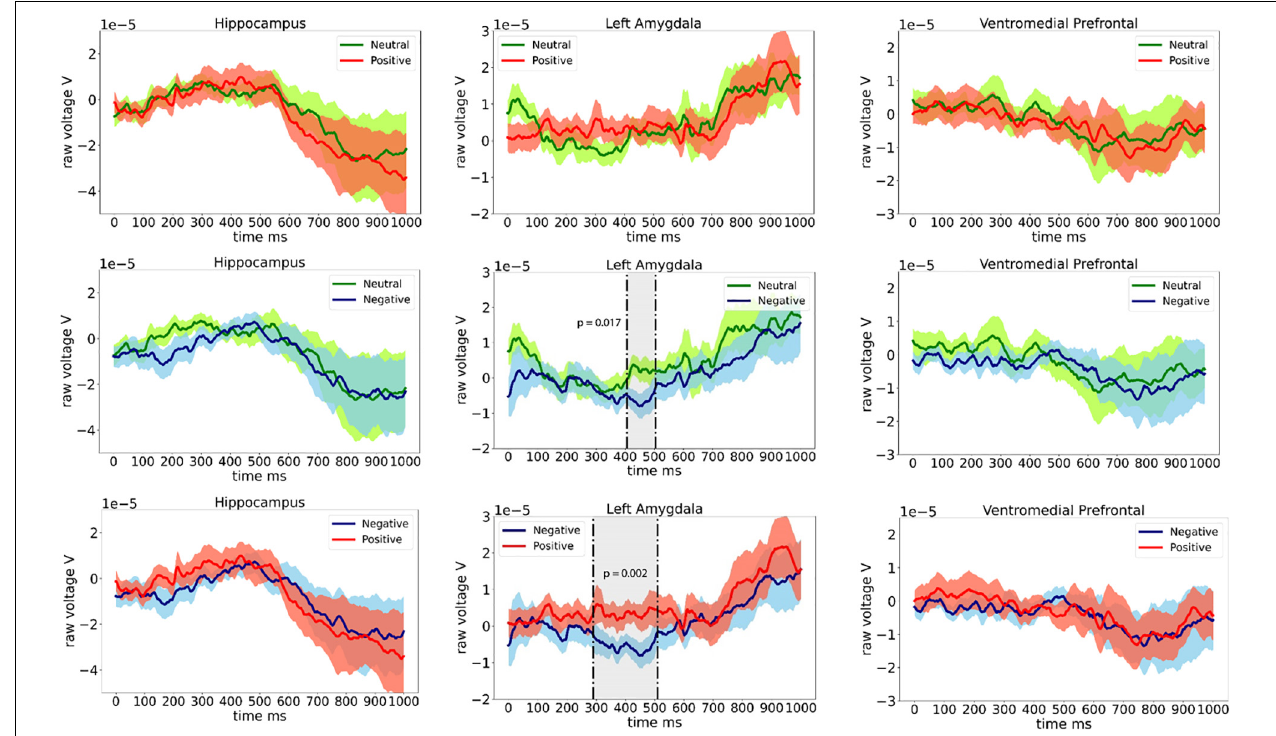
FIGURE 2 | Event related potentials (ERPs) recorded from the left hippocampus, left amygdala, and the left ventromedial prefrontal cortex from eight patients.